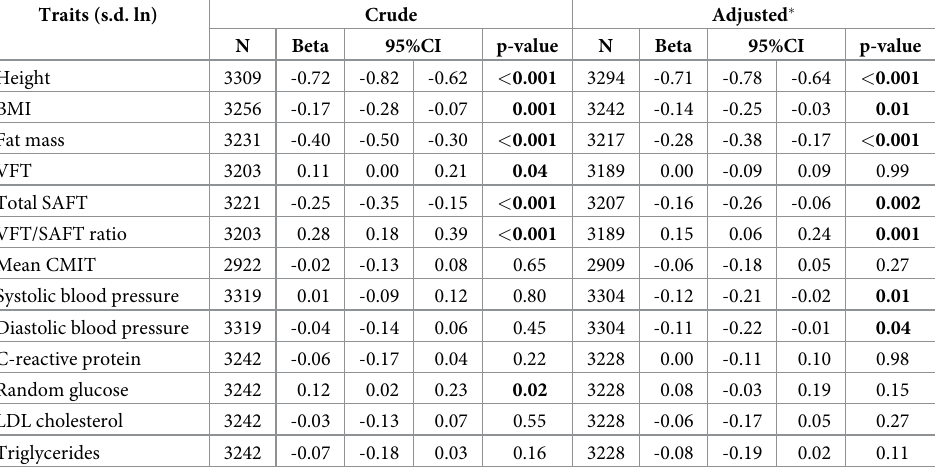
Table 4. Associations of stunting at age 2 years with cardiometabolic traits at age 30 years. Traits (s.d. ln) Crude Adjusted